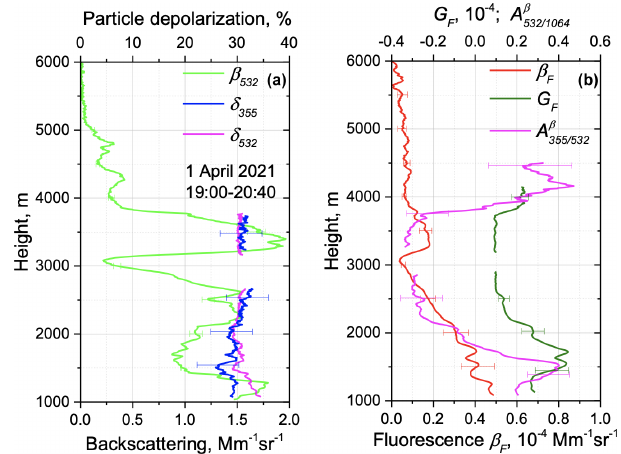
Figure 19. Vertical profiles of (a) backscattering coefficient β 532 and particle depolarization ratios δ 532 and δ 355 . (b) Fluorescence backscattering β F , fluorescence capacity G F , and backscattering Ångström exponent A β on 1 April 2021 for the period 532 / 1064 19:00–20:40UTC. Table 3. Intensive particle parameters from publications of Bur- ton et al. (2013), Nicolae et al. (2018), and Papagiannopoulos et al. (2018), together with values observed in current study for the urban, smoke, and dust